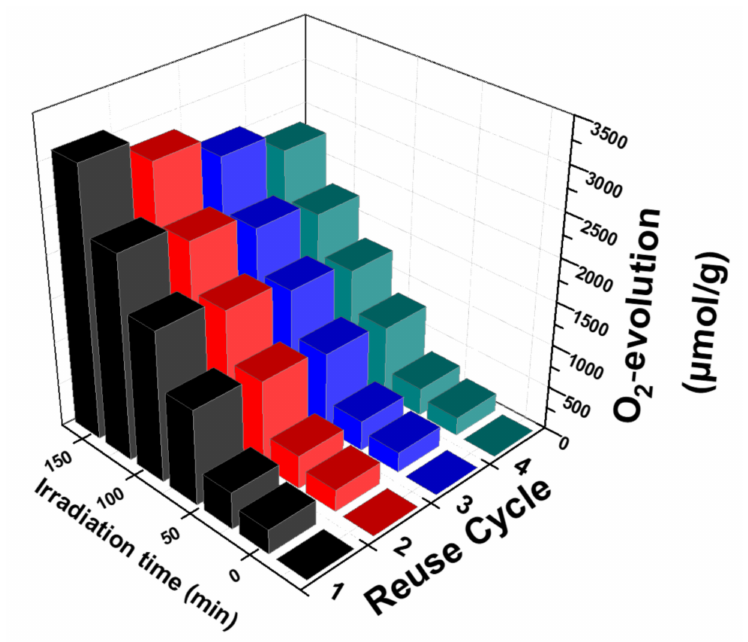
Figure 7. Photocatalytic O 2 evolution by sequential reuse of the same 5W-BiVO 4